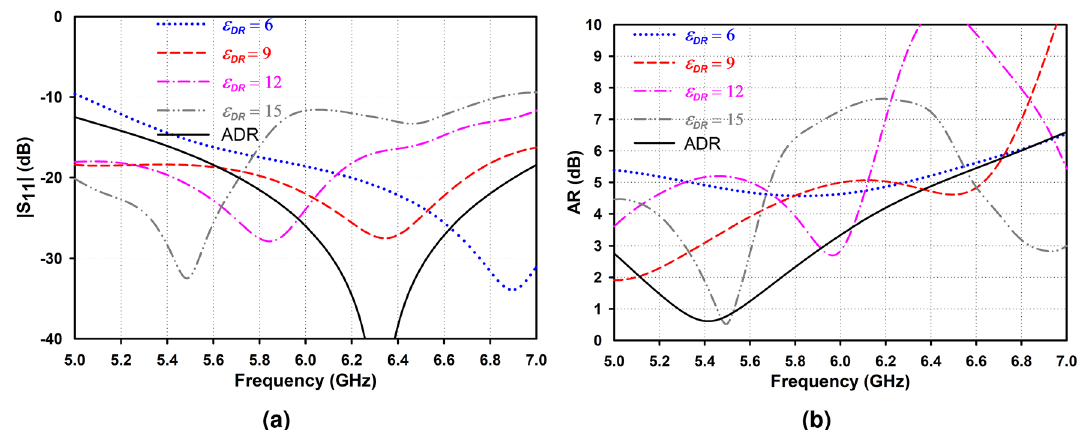
Figure 4. Simulated ( a ) | S 11 | and ( b ) AR of the IAS- and